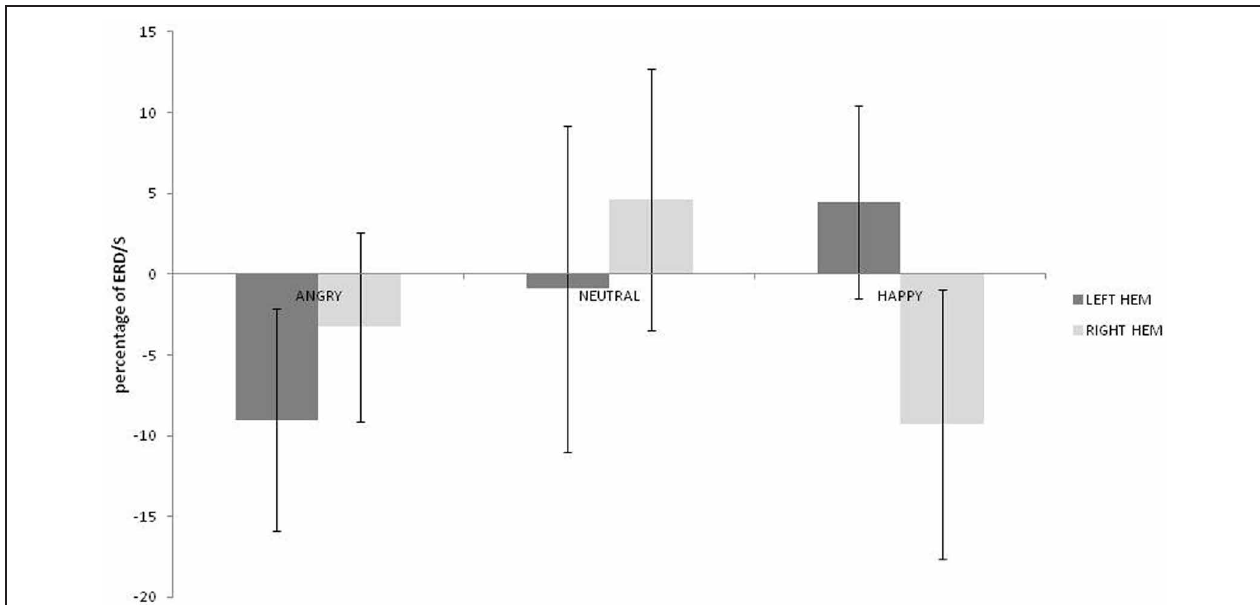
FIGURE 3 | Alpha ERD percentage-change over central sites for left and right hemispheres during angry, neutral, and happy conditions (positive values indicate ERD, negative scores indicate